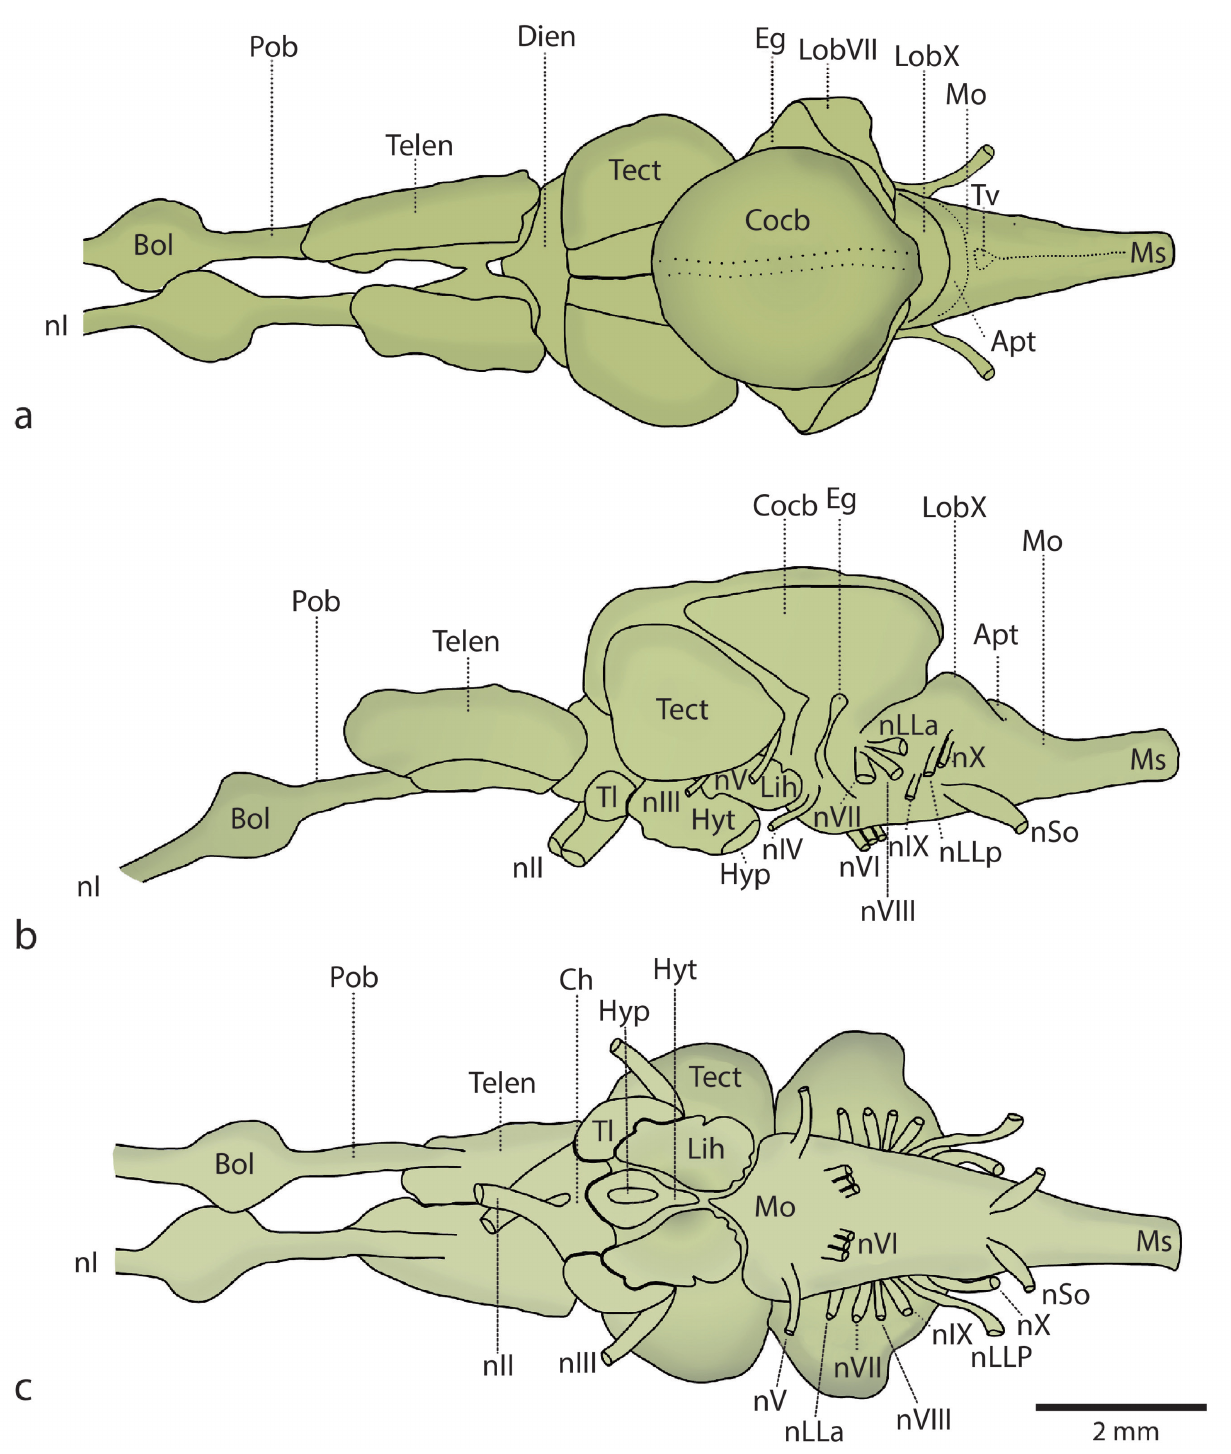
Fig. 4. Brain of Diplomystes mesembrinus (Siluriformes: Diplomystidae), LBP 449, 72.62 mm SL. a. dorsal; b. lateral and c. ventral views. Apt = Area postrema ; Bol = bulbus olfactorius ; Ch = chiasma opticum ; Cocb = corpus cerebelli ; Dien = diencephalon ; Eg = eminentia granularis ; Hyp = hypophysis ; Hyt = hypothalamus ; Lih = lobus inferior hypothalami ; LobVII = lobus facialis ; LobX = lobus vagi ; Mo = medulla oblongata ; Ms = medulla spinalis ; Pob = nervus tractus olfactorius ; Tect = tectum opticum ; Telen = Telencephalon ; Tl = Torus lateralis ; Tv = tela ventriculi . Cranial Nerves : nI = nervus olfactorius ; nII = nervus opticus ; nIII = nervus oculomotorius ; nIV = nervus trochlearis ; nV = nervus trigeminus ; nVI = nervus abducens ; nVII = nervus fascialis ; nVIII = nervus octavus ; nlla = nervus lineae lateralis anterior ; nllp = nervus lineae lateralis posterior ; nIX = nervus glossopharyngeus ; nX = nervus vagus and; nSo = nervus spino-occipitales